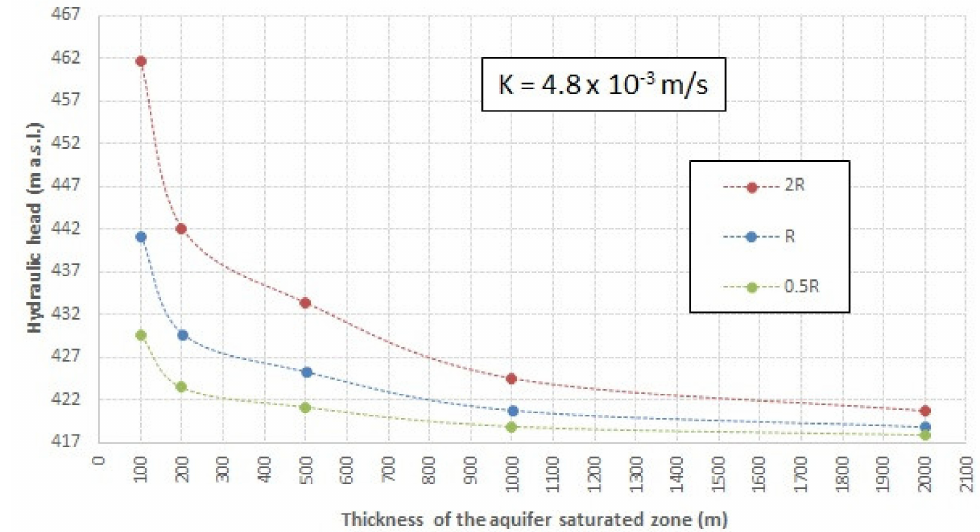
Figure 10. Relationship between the simulated maximum hydraulic head in the aquifer and the thickness of the saturated zone (TSZ), for di ff erent recharge amounts uniformly distributed on the catchment area: mean recharge (R), double recharge (2R) and halved recharge conditions (2R); dots represent the simulation steps carried